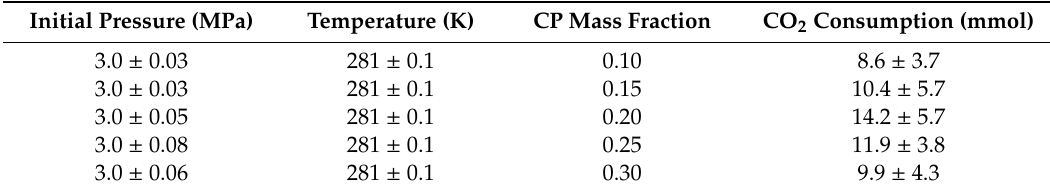
Figure 5. Pressure ( a ) and CO 2 consumption ( b ) profiles in the formation of mixed CP-CO 2 hydrates. Table 2. Total CO 2 consumptions in hydrate formation with different CP mass fractions. Initial Pressure (MPa)